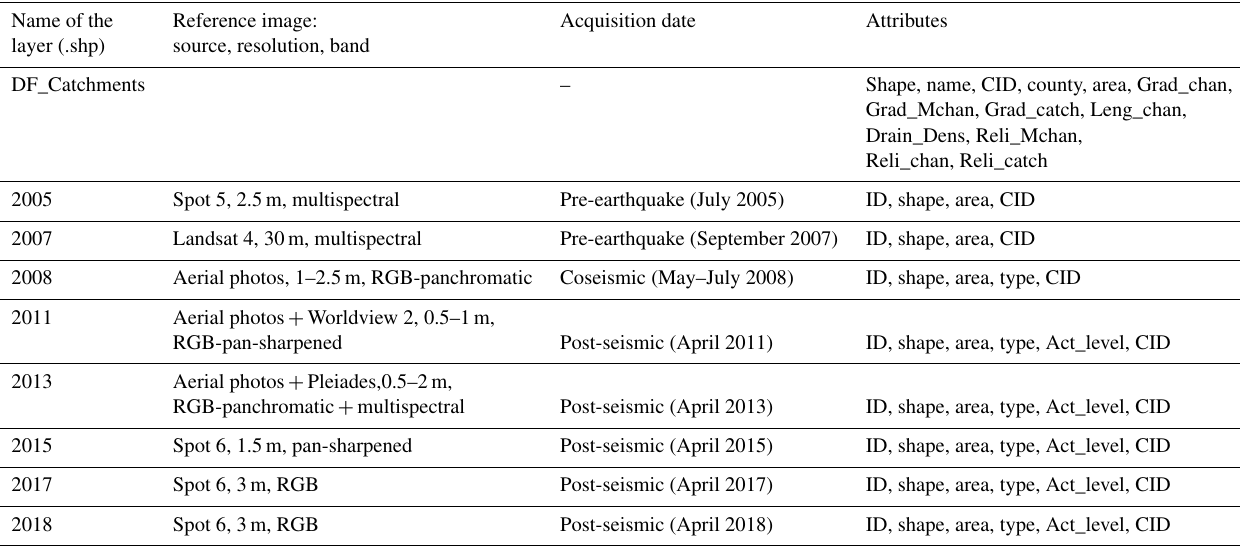
Table 1. Reference images used to map the landslides, acquisition date and attributes of each layer contained in the dataset. An additional shape file is provided to define the catchment boundaries and have a simple characterisation (CID: catchment identifier, catchment name and county, gradient and internal relief, drainage density and channel length).